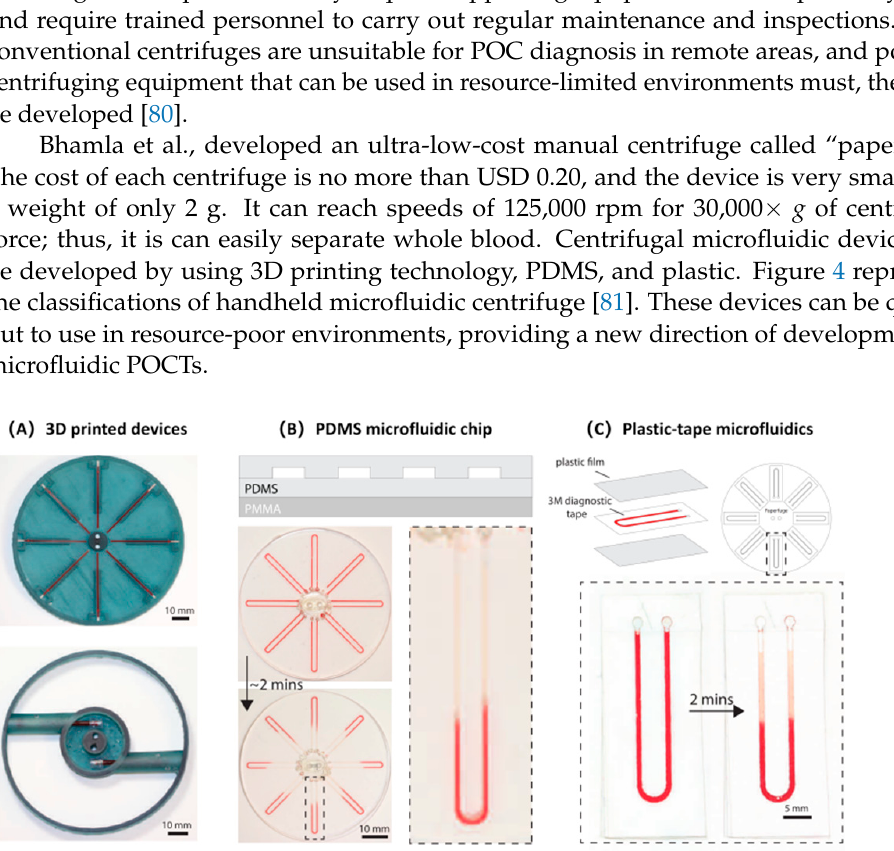
Figure 4. The classifications of handheld microfluidic centrifuge. ( A ) Handheld microfluidic centrifuge made with 3D printing technology. ( B ) PDMS handheld microfluidic centrifuge. ( C ) Plastic handheld microfluidic centrifuge. Reprinted with permission from [81]. Copyright 2017 Springer Nature.